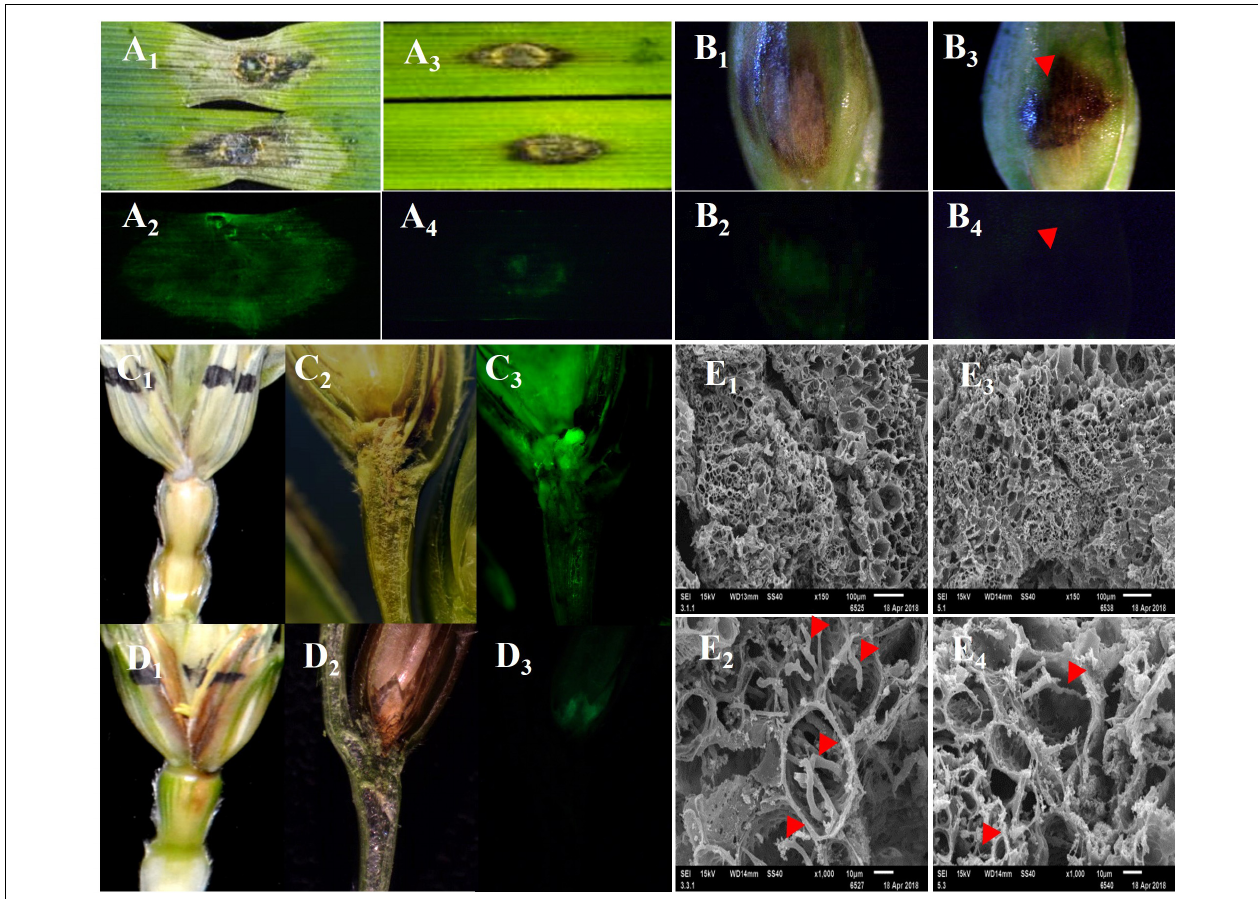
FIGURE 1 | The disease symptoms and movement of F. graminearum in detached leaves, glumes, and spikes of susceptible (Jimai 22) and resistant (Sumai 3) plants after infection of F. graminearum eGFP-PH-1. The black necrotic lesions (BNLs) were detected in Sumai 3, which effectively limited the size of disease symptoms and hypha spread of F. graminearum among tissues. (A 1 ,A 2 ,B 1 ,B 2 ,C 1 –C 3 ) Show detached leaves, glume, and spike of Jimai 22 after infection of F. graminearum that were photographed under regular light and green fluorescent light, respectively. (A 3 ,A 4 ,B 3 ,B 4 ,D 1 –D 3 ) Show the detached leaves, glume, and spikes of Sumai 3 after inoculation of F . graminearum that were photographed under regular light and green fluorescent light, respectively. (E 1 –E 4 ) Show the organizational structure of the nodes which connect the inoculated floret to the rachis of Jimai 22 and Sumai 3, respectively, at 12 DAI under SEM. The red arrows point to hyphae of F. graminearum in the